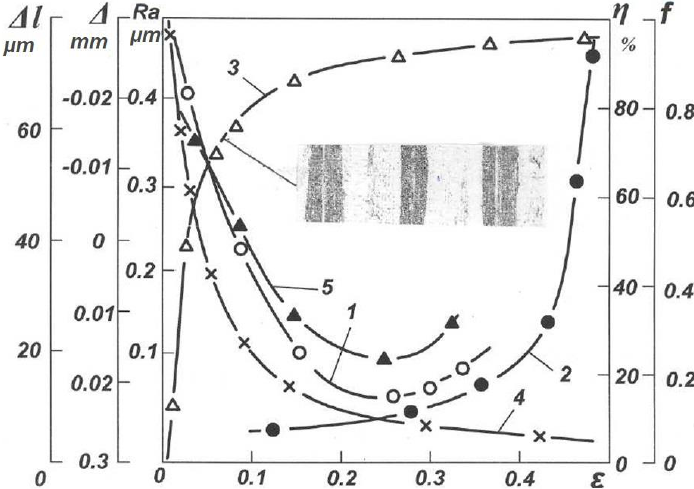
Fig. 2. Dependences of roughness Ra (1), accuracy Δ holes in a circle (2), bearing surface η (3), coefficient of friction f (4) and wear of a part Δl (5) on relative deformation ε at DB of a sleeve from steel 10. In the center – photomicrograph (  80) of the hole area with regular annular microrelief: light stripes – support platforms, dark –